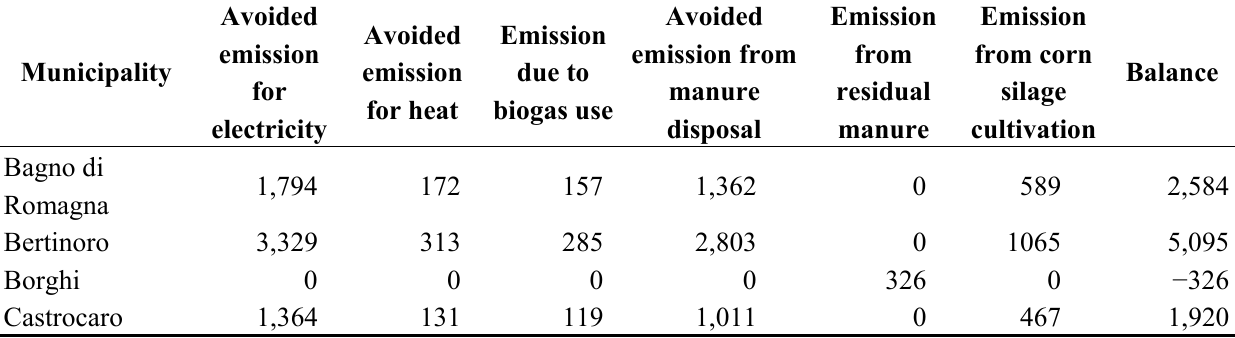
Table 13. GHG emissions (all values in Mg CO